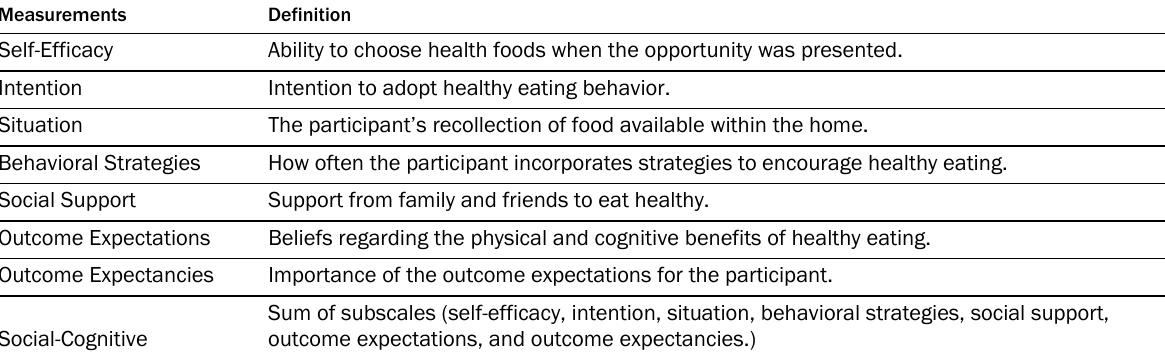
Table 2. Dietary-related Social-Cognitive Factor